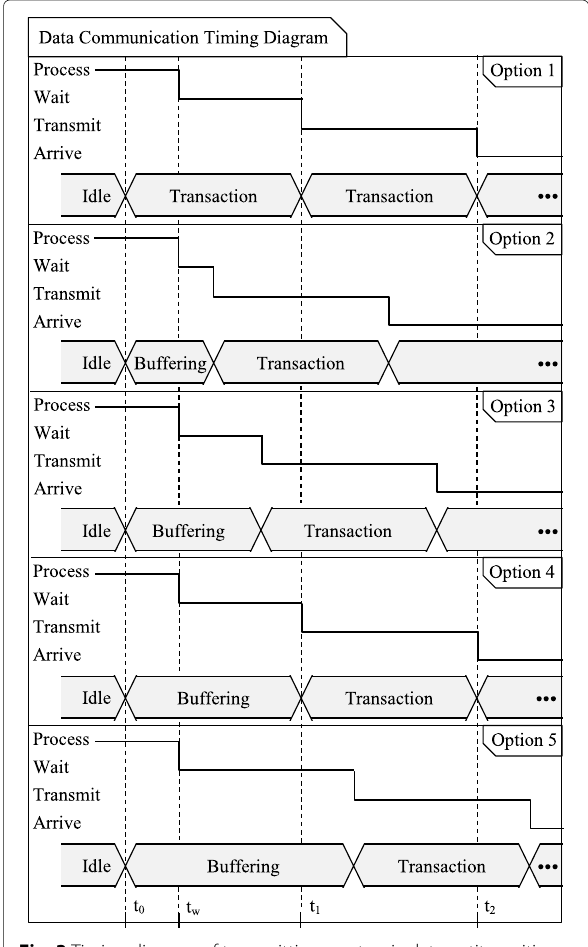
Fig. 3 Timing diagram of transmitting an atomic data entity waiting at t